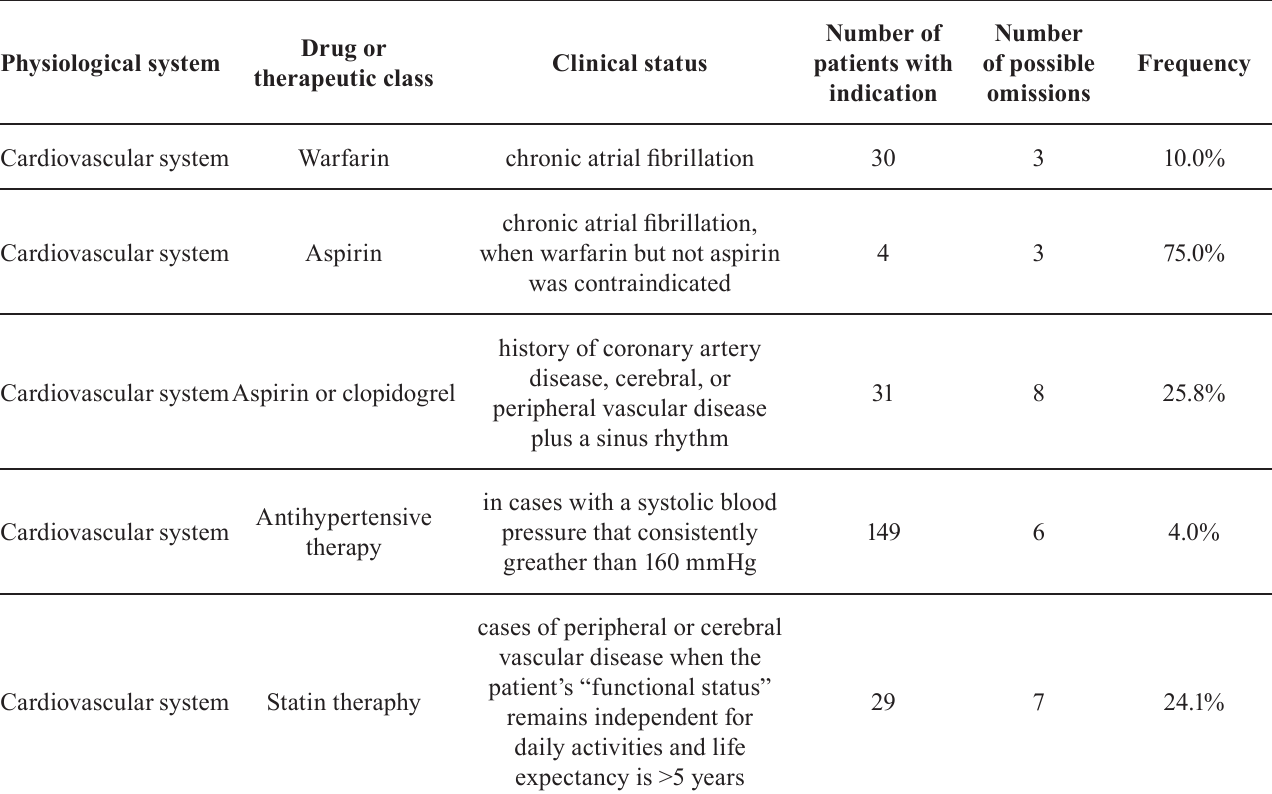
TABLE III – Main drugs or therapeutic classes that presented possible prescribing omissions at hospital discharge, according